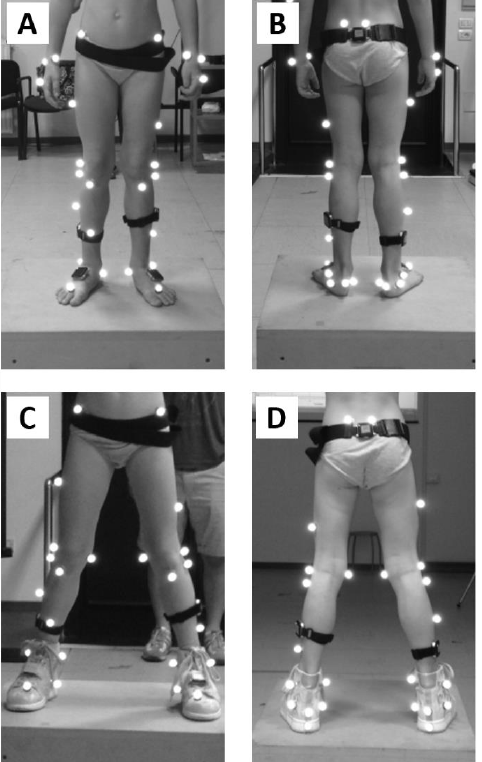
Figure 2. Markers and MIMU sensors positioning. Only a subset of the depicted markers was used in this study to implement the Plug-in-gait protocol. The MIMU sensor positioned on the pelvis was not used to perform any of the analysis reported here. ( A , B ): Front and rear views of the barefoot condition; ( C , D ): Front and rear views of the shoed condition.